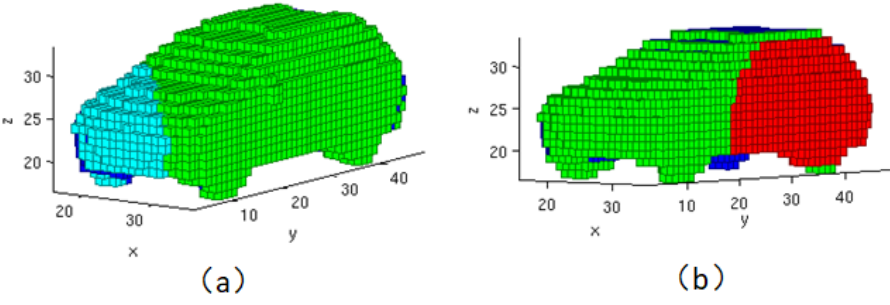
Figure 5. Illustration of 3D voxel pattern. Green of 3D voxel patterns represents visible in ( a , b ). Cyan of 3D voxel patterns represents truncated in ( a ). Red of 3D voxel patterns represents occluded in ( b ).